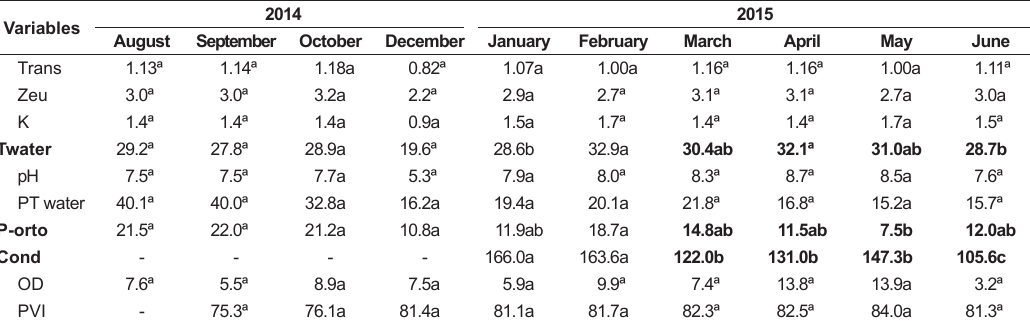
Averages followed by the same letter in the line do not differ from one another according to the Tukey test at 5% probability. Trans = water transparency; Zeu = Euphotic zone; pH, Twater = water temperature; PT water = Total phosphorus; PVI = macrophyte infestation percentage; P-orto = dissolved phosphorus; Cond = Conductivity; K = light attenuation coefficient; OD = Dissolved oxygen. Acta Limnologica Brasiliensia, 2018, vol. 30, e102